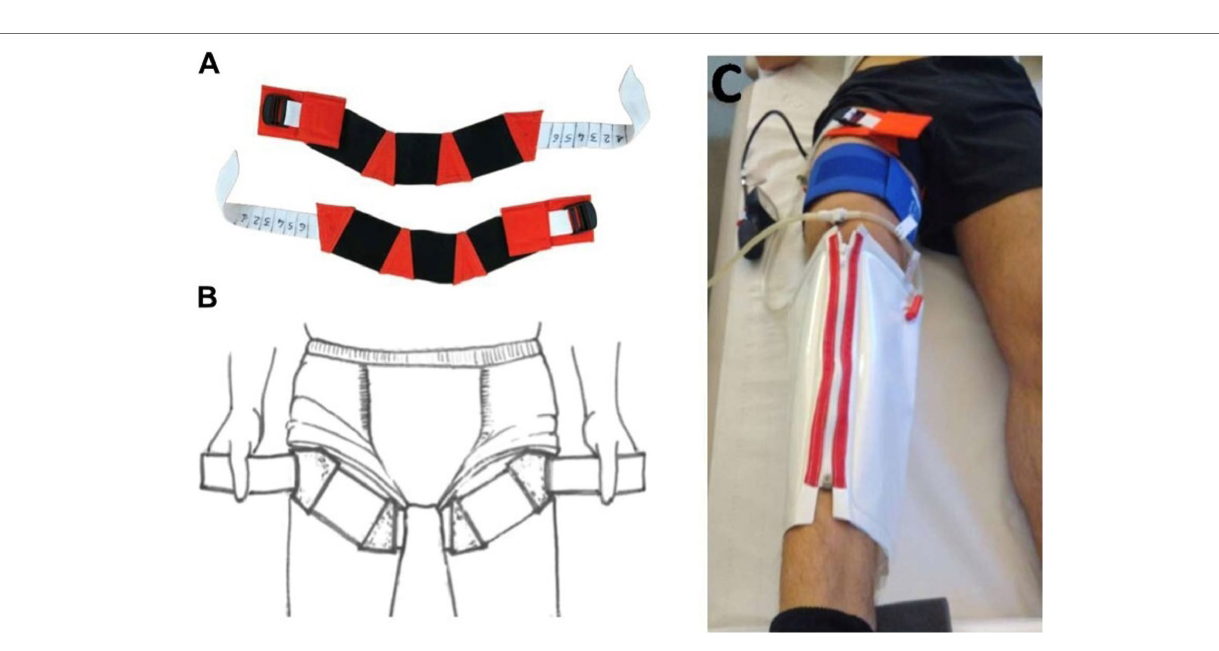
FIGURE 2 | Illustration of thigh cuffs. (A) Thigh cuffs are elastic strips that can be adjusted to the size of the thigh with a clamping segment (white segment); (B) Thigh cuffs are worn on the upper thigh. (C) Individual adjustment of thigh cuffs with plethysmography to apply a 30-mmHg pressure on the upper thigh, performed at baseline data collection (BDC)-2 (Photo